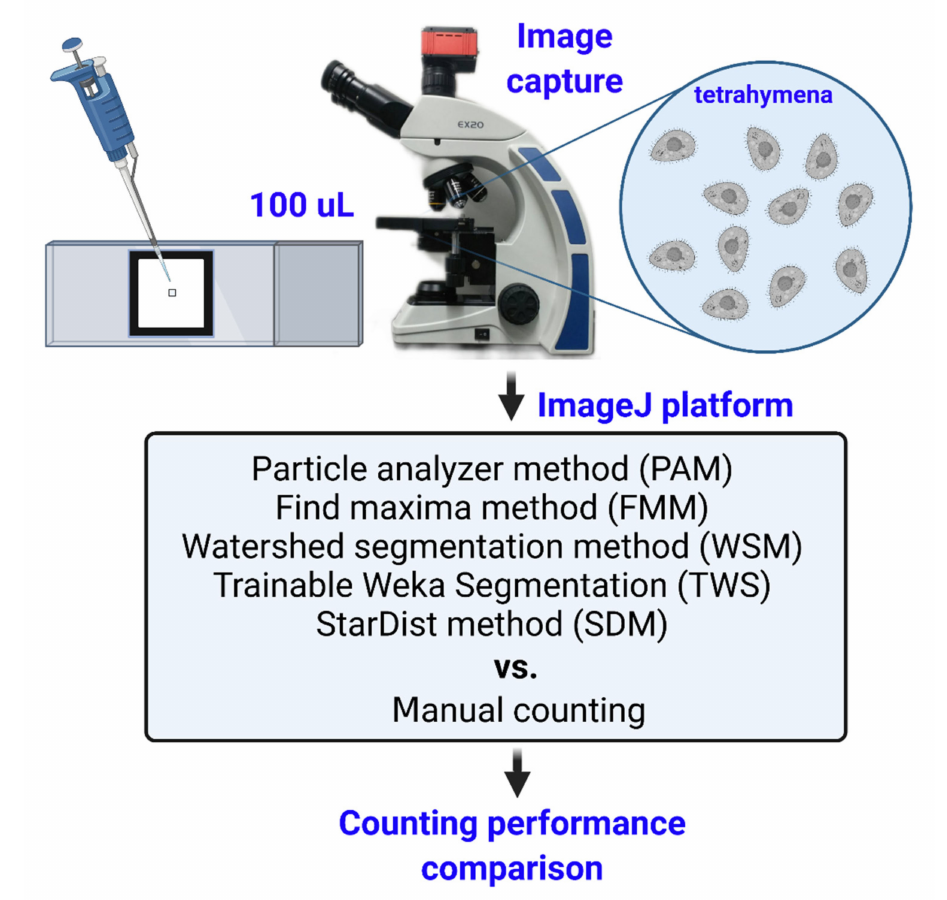
Figure 1. Experimental overview of analysis pipeline for Tetrahymena counting. First, 100 µ L Tetrahy- mena samples were loaded into a protozoa counting chamber and covered with cover slide. Next, video recording was conducted for 10 s with 40 × magnification. Later, videos were periodically output as 10 frames at 1 s interval. Finally, images were analyzed by five different cell counting methods and compared with manual counting method as the golden